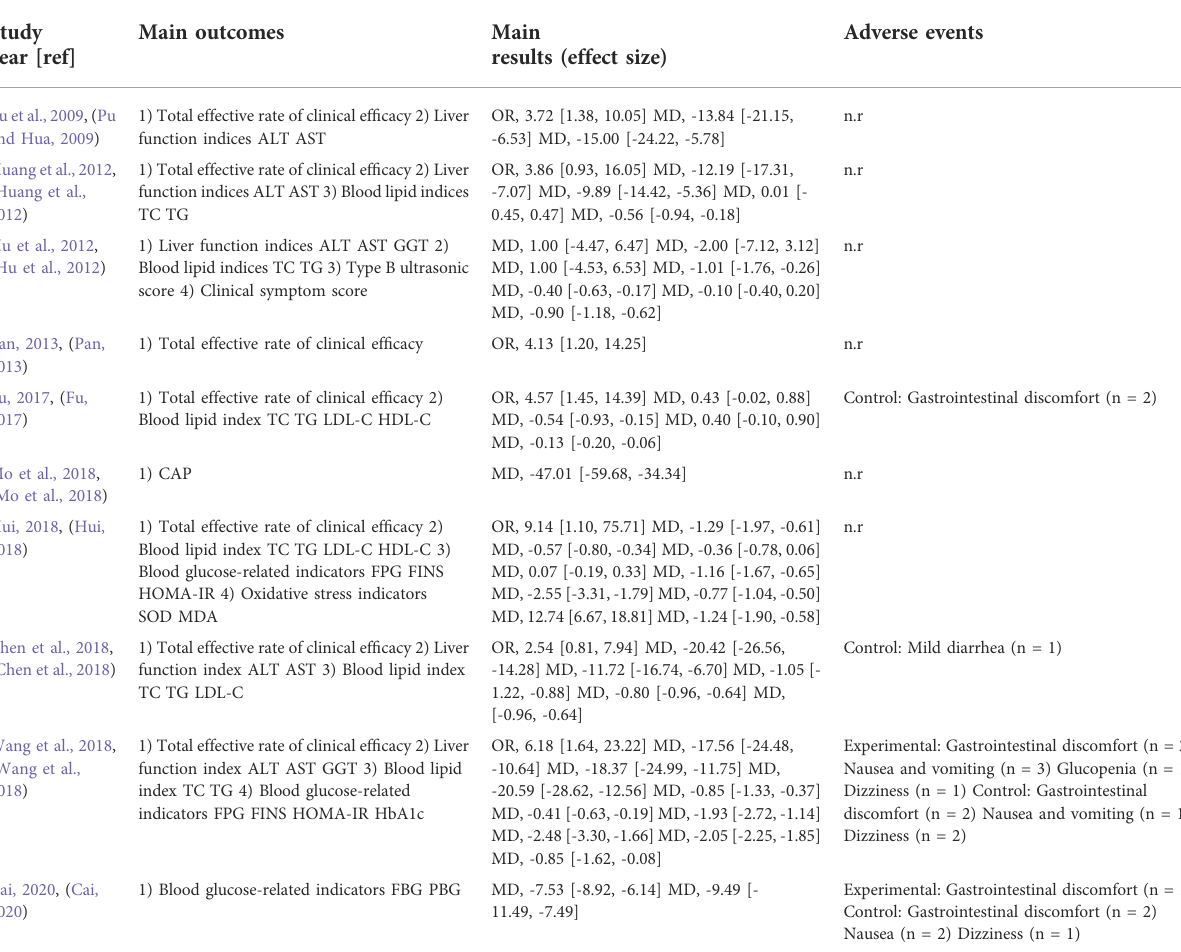
TABLE 5 Main outcomes of included RCTs.